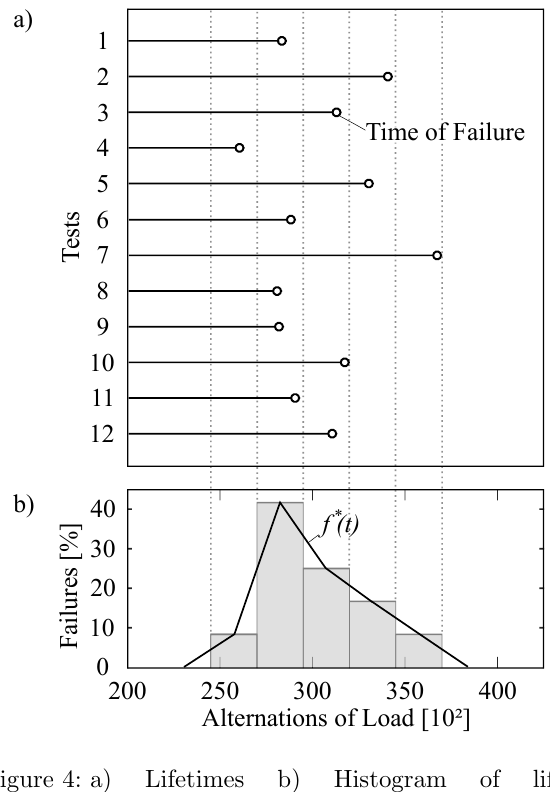
Figure 4: a) Lifetimes b) Histogram of life- times Bertsche and Lechner (2004)